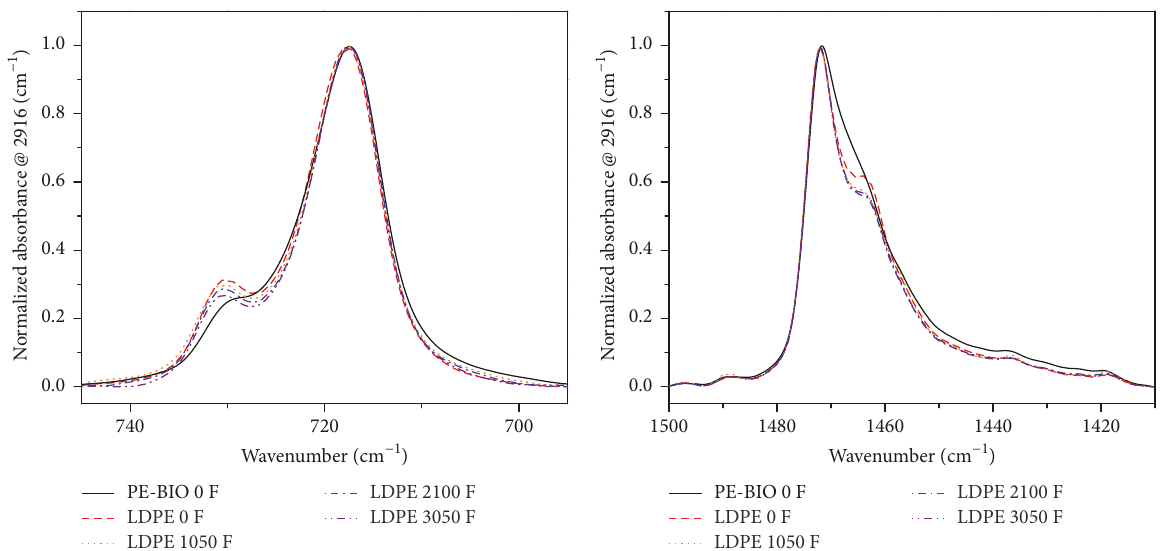
(a) Infrared band of rocking vibration of methylene, CH 2 , from LDPE irradiated with CO 2 laser at different fluencies